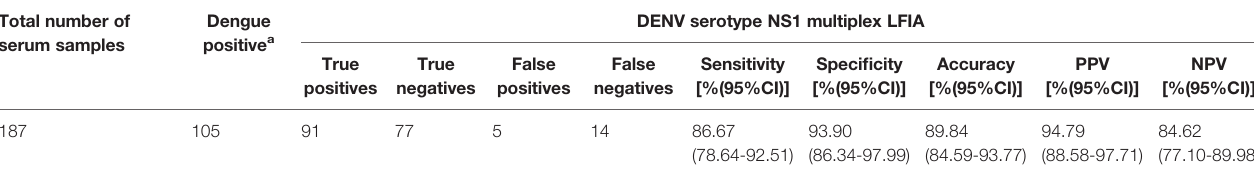
TABLE 8 | Overall diagnostic accuracy and sensitivity of DENV serotype NS1 multiplex LFIA. Total number of serum